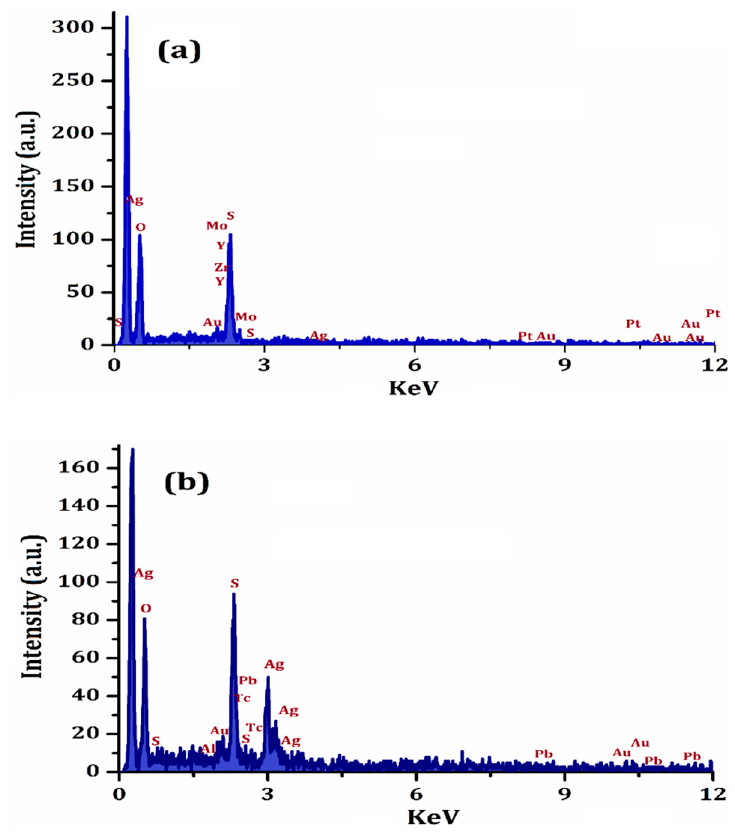
Figure 6. EDX spectra of ( a ) Dowex resin beads and ( b ) CR-AgNCs.